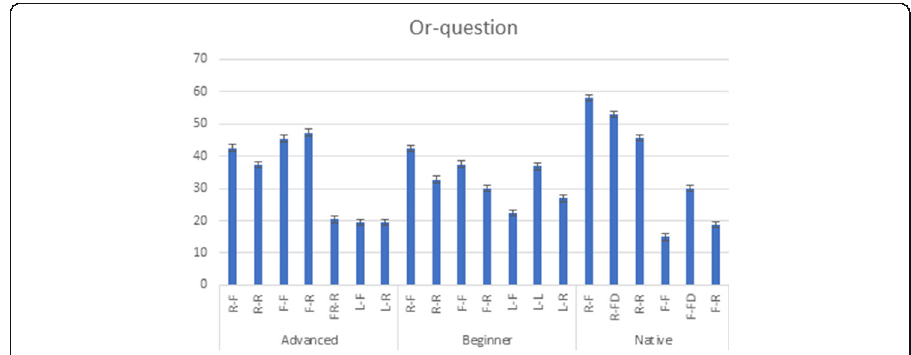
Fig. 3 Mean proportion of final tunes of Or- questions by speaker groups. Y-axis: mean percentage